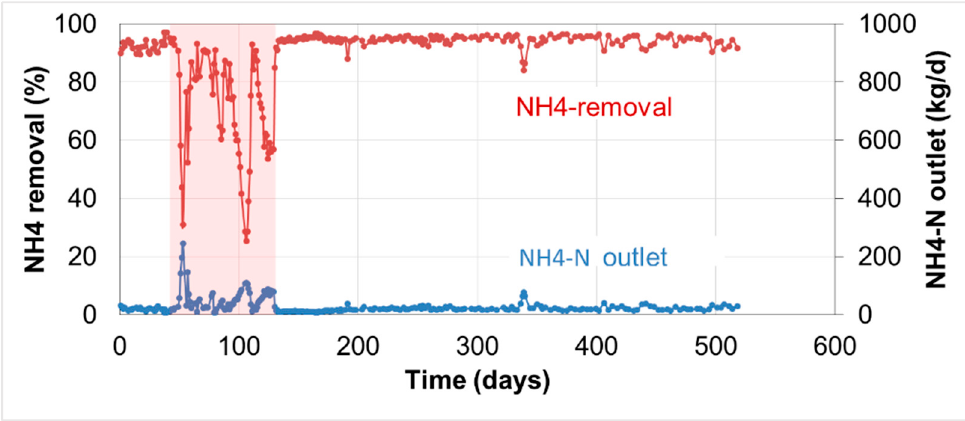
Figure 10. NH 4 -N removal and NH 4 -N outlet load before and after dosing of micro-nutrients at an ANAMMOX reactor treating MAD reject liquor in combination with co-digestion industrial residues.